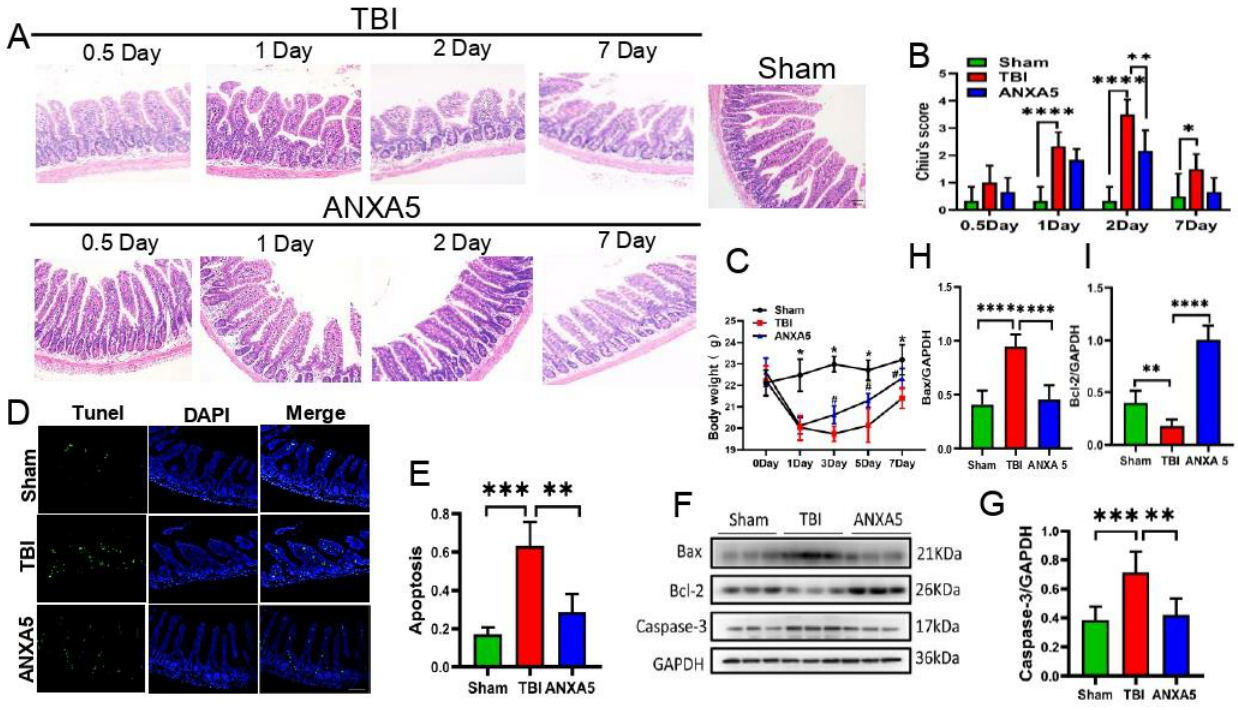
Figure 1. ANXA5 reduces intestinal lesions after TBI. ( A ) Representative images of ileal HE staining (×200 magnification) at 0.5, 1, 2, and 7 days after TBI (scale bar = 40 µm). ( B ) Chiu’s scores of the intestinal mucosa. Intestinal injury peaked on day 2 after TBI and then declined ( n = 6 mice/group). ( C ) Compared with TBI group, the weight of mice in ANXA 5 treatment group increased faster, and the body weight increased significantly on day 5 post-injury. ( n = 10 mice/group). * p < 0.05 vs. sham group; # p < 0.05 vs. TBI group (repeated measures analysis of variance followed by Bonferroni’s post hoc test). ( D , E ) Representative immunofluorescence images of TUNEL staining in ileum tissue (scale bar = 100 μm). The average number of TUNEL -positive cells (in green) per ×200 field was quantified. ANXA5 treatment significantly reduced apoptotic cells compared to the TBI group ( n = 6 mice/group). ( F – I ) Immunoblotting showed that intestinal caspase-3 and Bax increased signifi- TBI. Conversely, Bcl2 decreased significantly after TBI, and ANXA5 treatment could reverse this trend ( n = 6 mice/group). Data are expressed as mean ± SD. * p < 0.05, ** p < 0.01, *** p < 0.001, **** p <